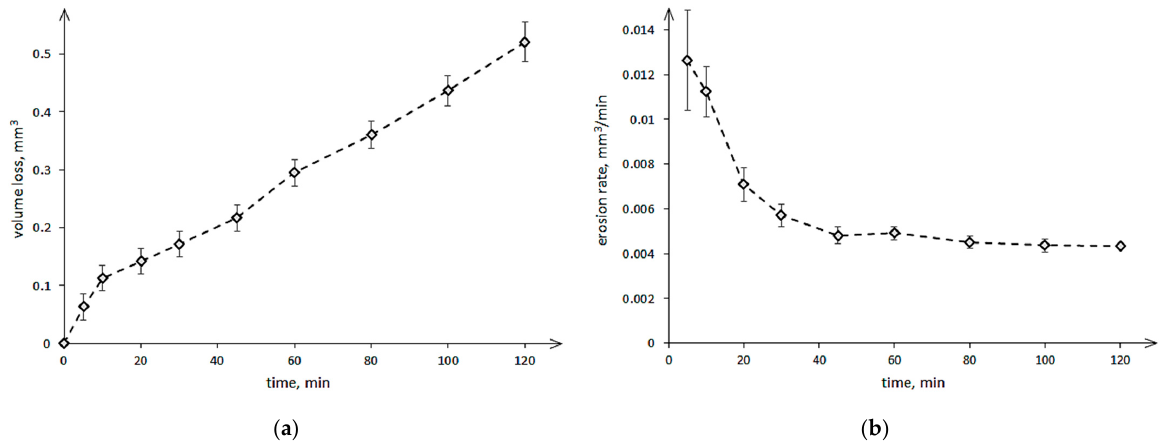
Figure 5. Results of the cavitation erosion of nickel coating: ( a ) volume loss in time and ( b ) cumulative erosion rates in time.